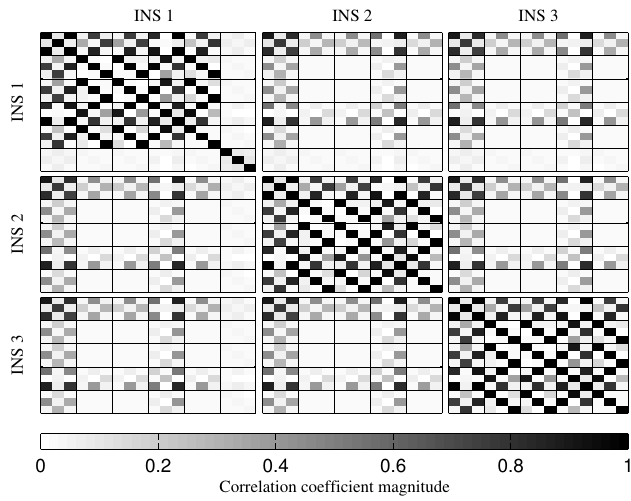
Figure 17. Graphical represetation of the correlation between the states of the navigation filter at the 674th second of simulation, when only the relative attitude constraint is